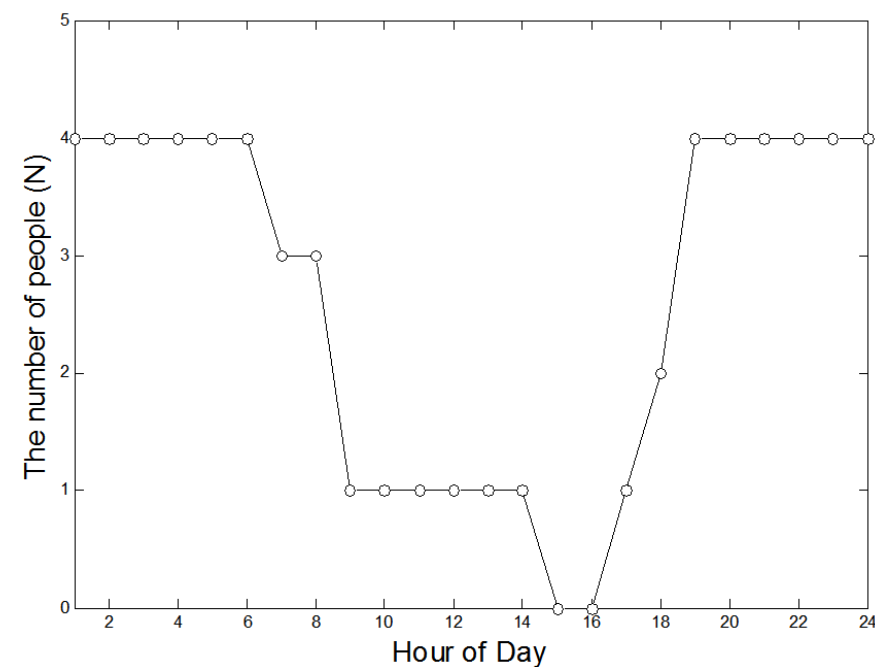
Figure 11. The number of people in the house over the course of a day.